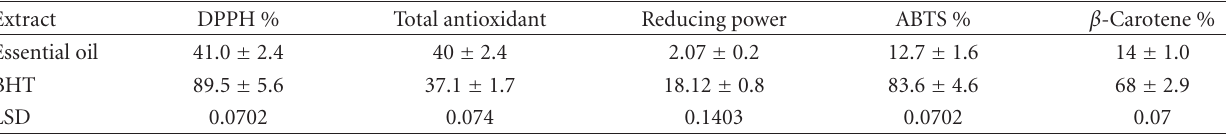
Table 7: Antioxidant activity (%) of essential oil of E. compressa collected during spring compared with BHT as standard. Extract